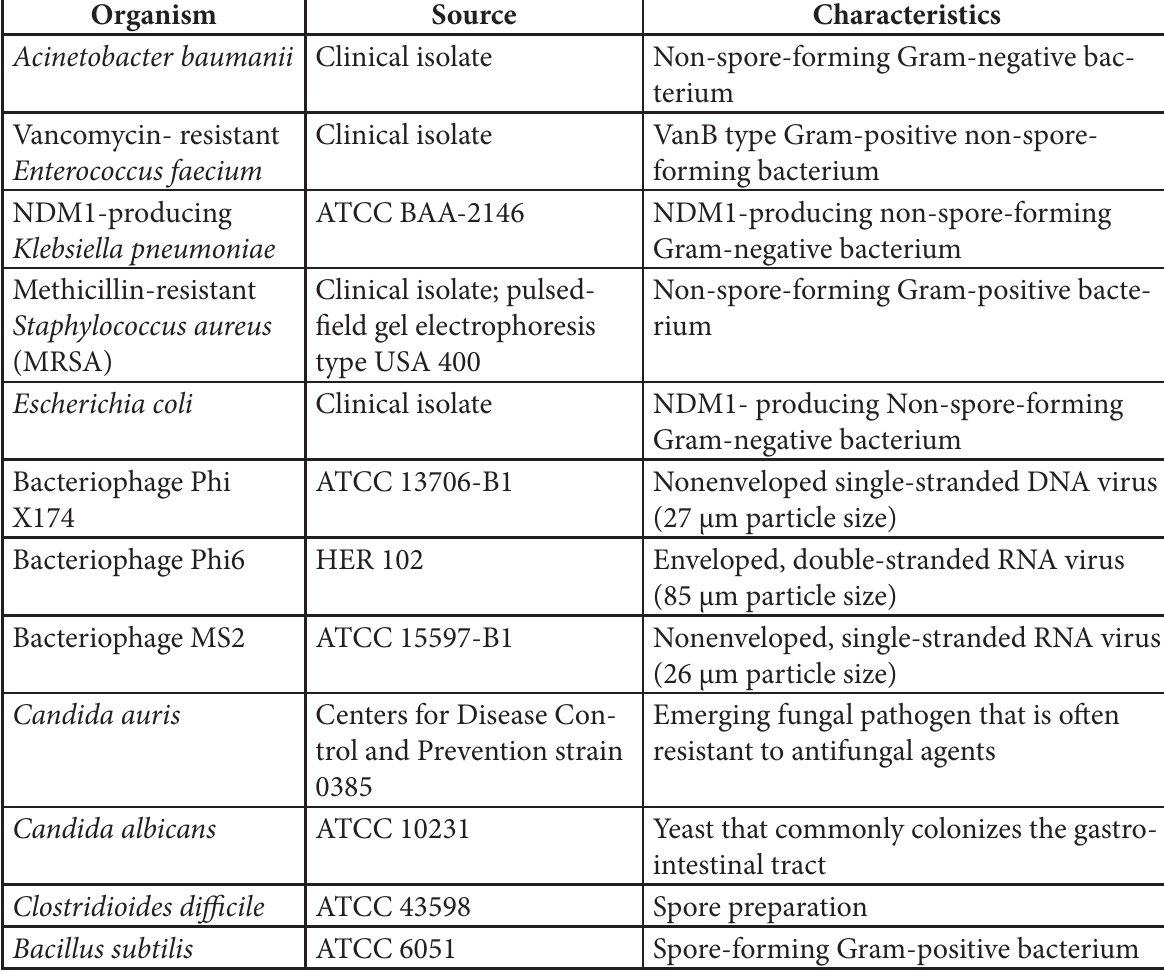
Table 1. Characteristics of the test